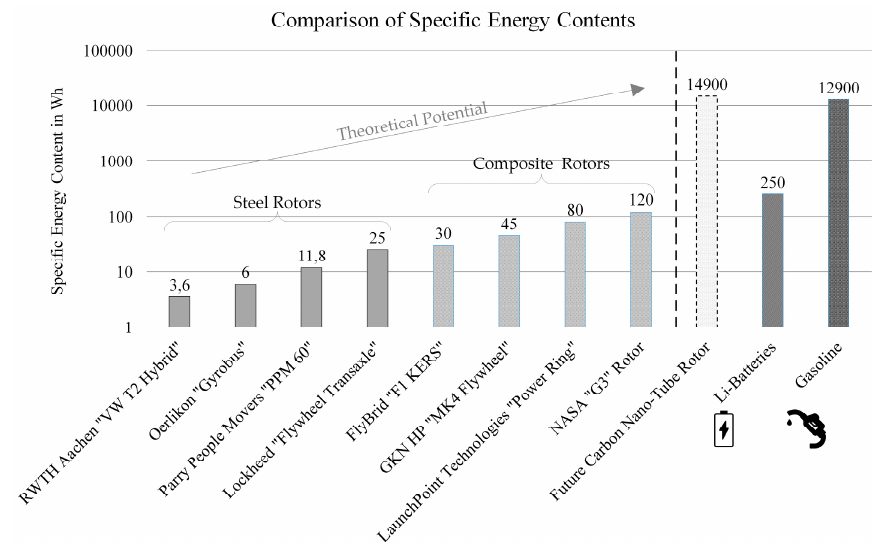
Figure 3. Comparison of specific energy content of existing FESS rotors and possible future carbon nanotube rotor with Li-Ion batteries and fossil fuels. Please also note the logarithmic scale.